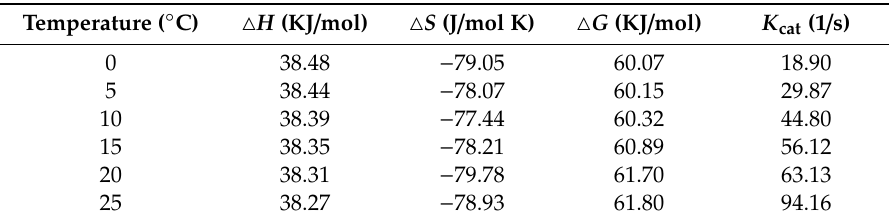
Table 6. Thermodynamic constants of the